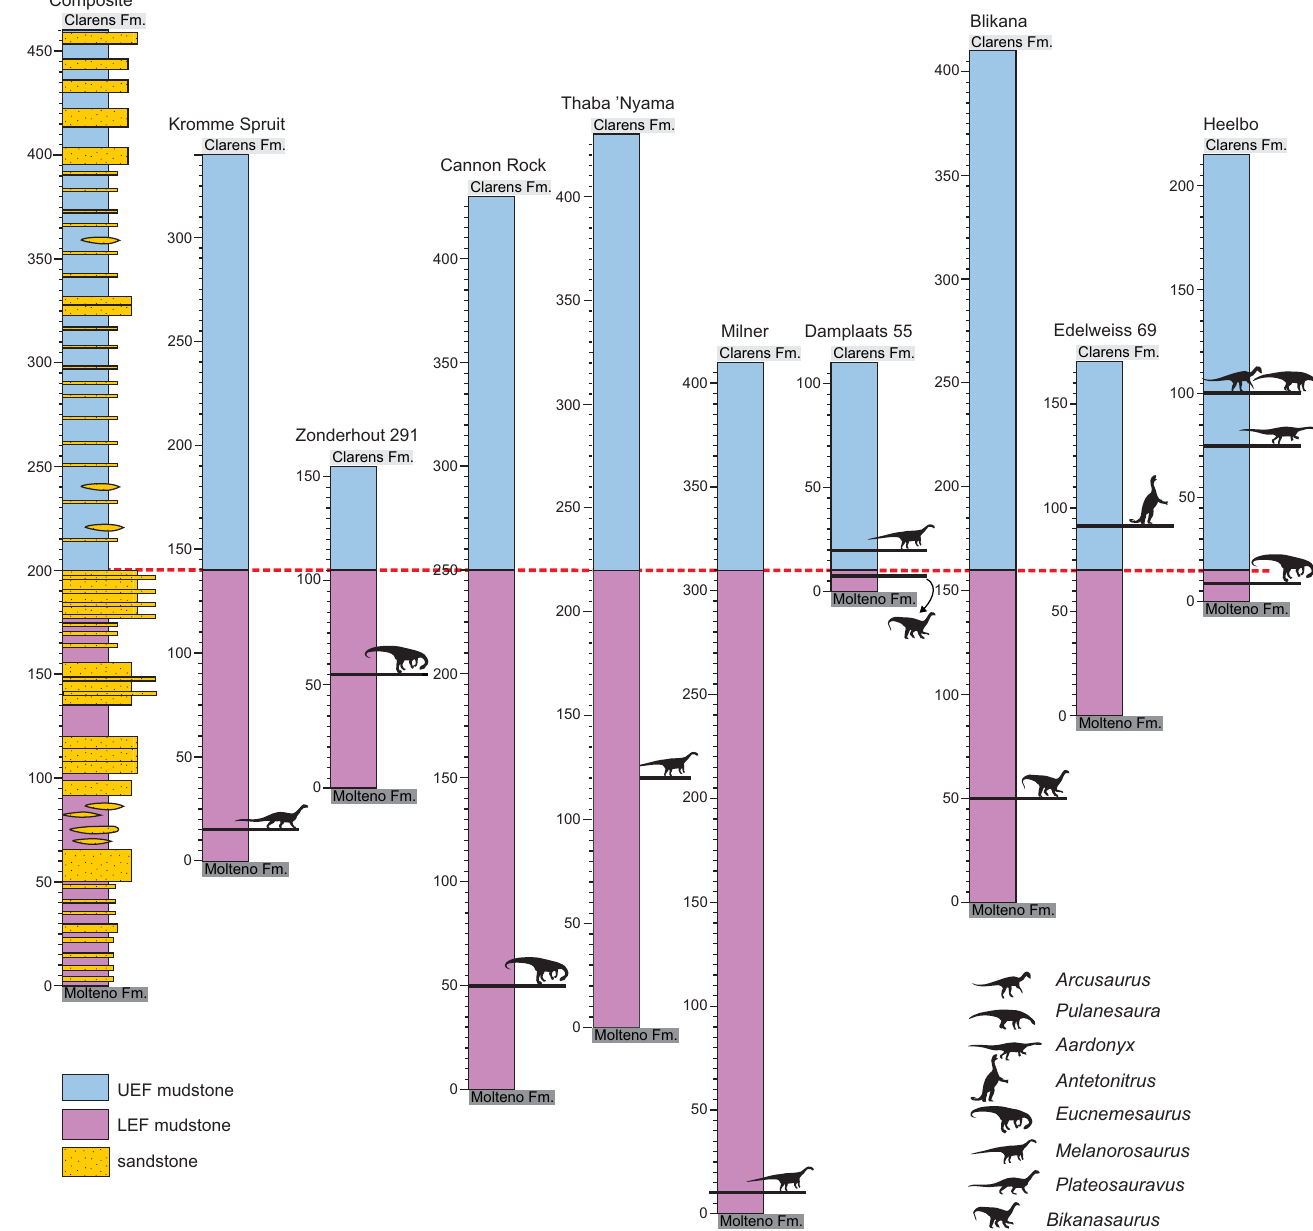
Fig. 3. Schematic sections of the sauropodomorph specimen localities discussed in the text. For each locality, the stratigraphic positon of (i) the fossil specimens, (ii) the lower and upper ranges of the Elliot Formation, and (iii) the LEF–UEF contact are shown. See text and Table 1 for details, and Figs. 1 and 2 for the geological maps of the locations. The composite stratigraphic section of the Elliot Formation is modified from Bordy and Eriksson